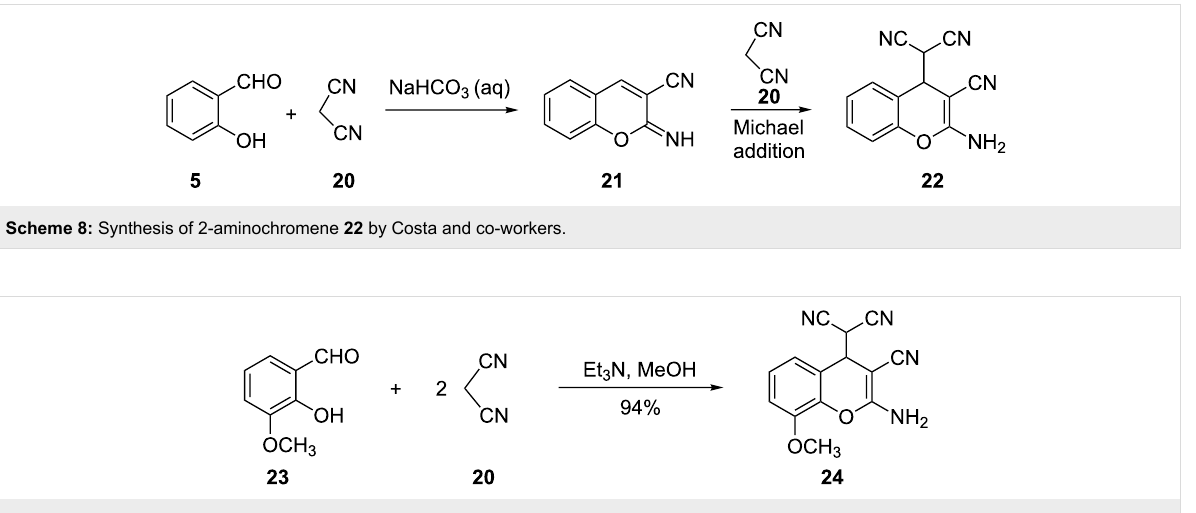
Scheme 9: Costa and co-workers used Et 3 N in the synthesis of 2-aminochromene 24